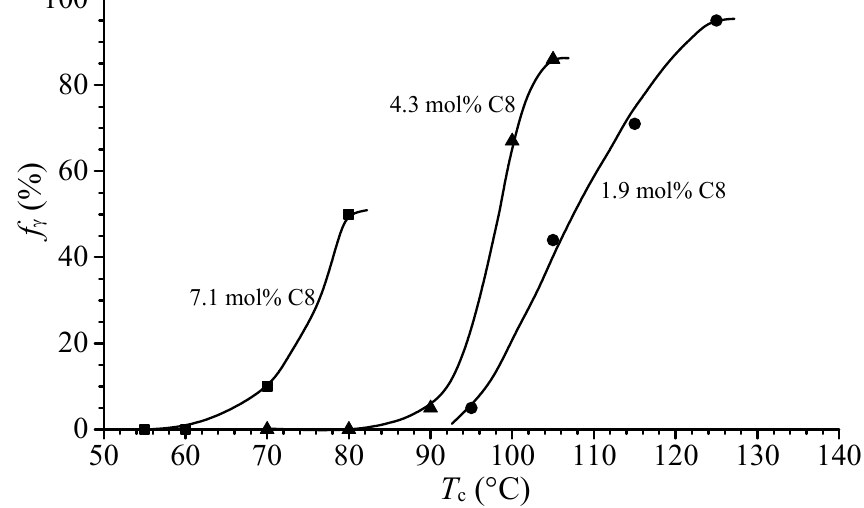
Figure 4. Relative amount of γ form ( f γ ) that crystallizes from the melt in samples of iPPC8 copoly- mers isothermally crystallized from the melt at the crystallization temperatures, T c , as a function of the crystallization temperature T c . ( (cid:108) ) sample iPPC8-1 with 1.9 mol% of octene, ( (cid:78) ) sample iPPC8-2 with 4.3 mol% of octene, ( (cid:4) ) sample iPPC8-3 with 7.1 mol% of octene.